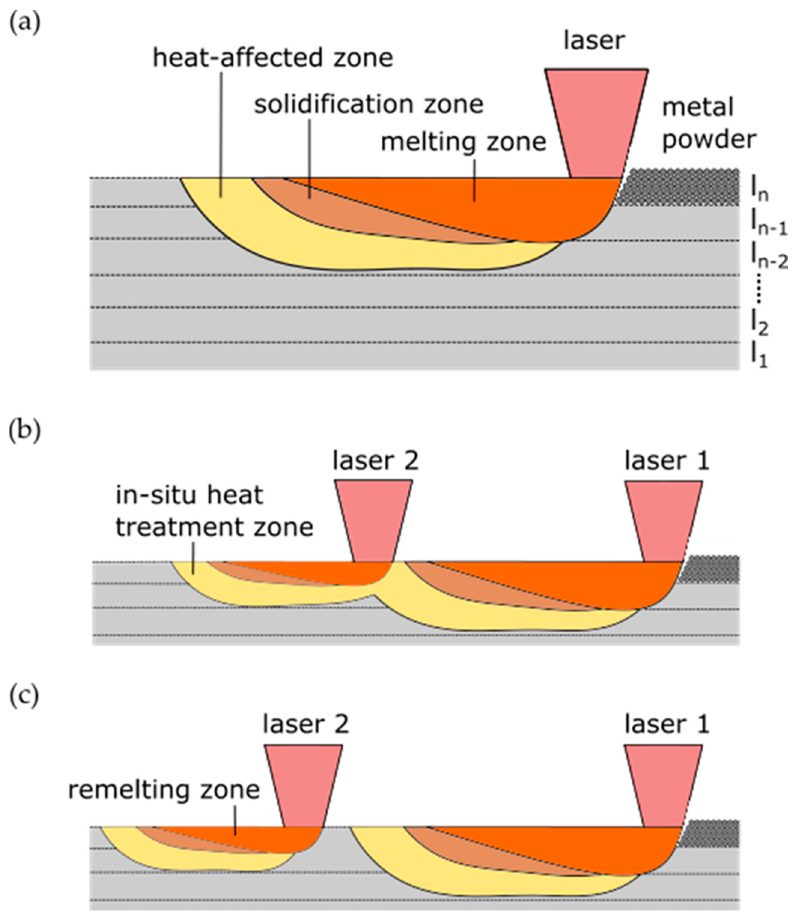
Figure 5. Longitudinal section of the PBF-LB processing with ( a ) single laser, ( b ) dual-laser in-situ heat treatment and ( c ) dual-laser remelting strategy. heat treatment and ( c ) dual-laser remelting